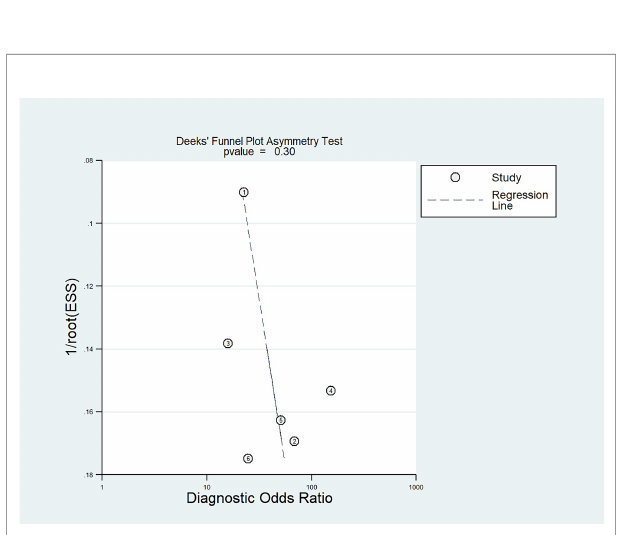
FIGURE 5 | Deeks ’ funnel plot used to evaluate potential publication bias.